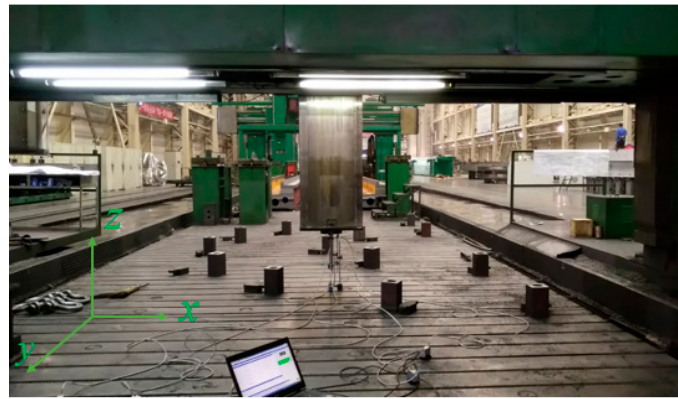
Figure 5. Data acquisition of thermal error.